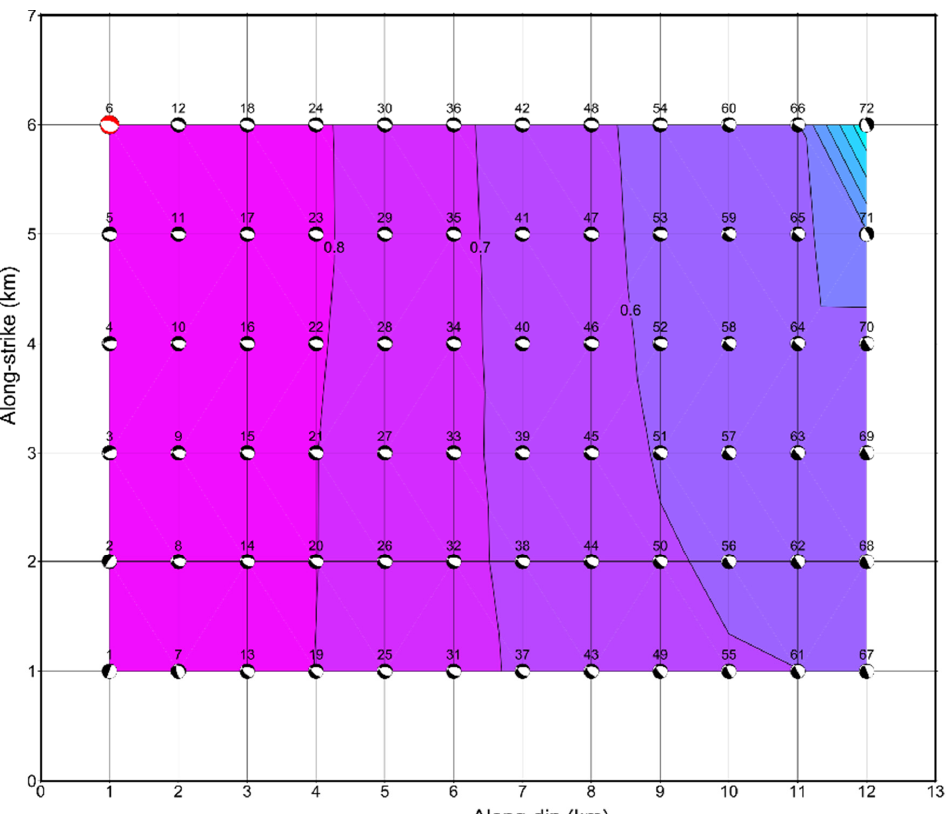
Figure A7. Correlation diagram for the grid trial sources used in the inversion. Higher correlation is observed up-dip, strongly suggesting a very shallow seismic source. The enlarged red beachball corresponds to the final solution (source #6).